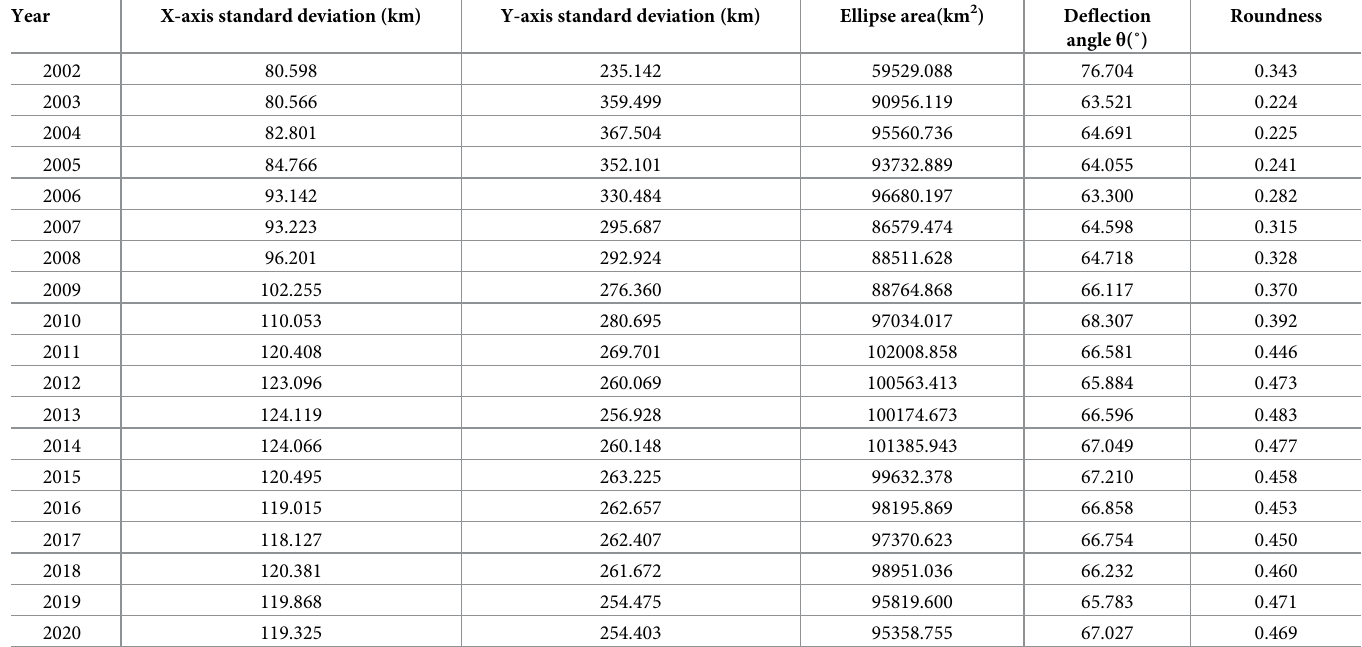
Table 4. Results of the standard deviation